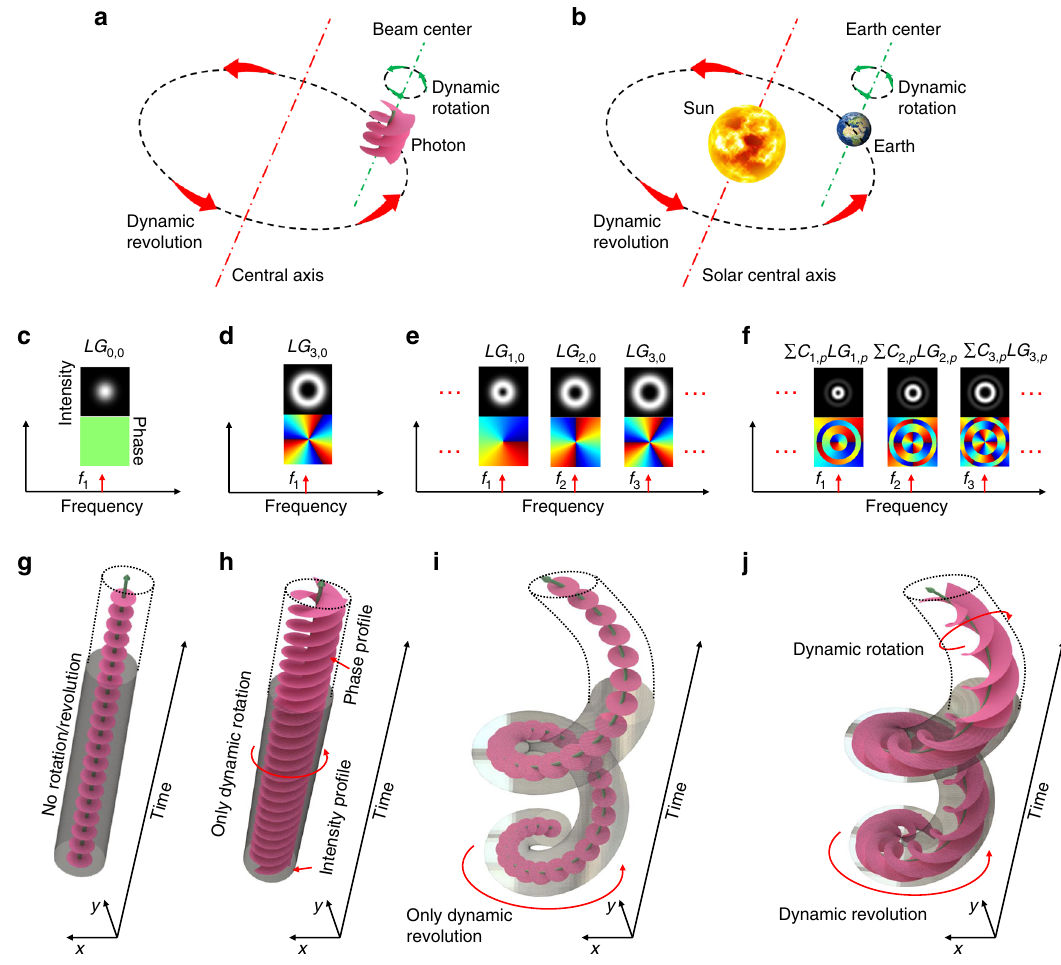
Fig. 1 Generating a spatiotemporal beam exhibiting both dynamic rotation and revolution. a , b Illustration of a light beam that dynamically rotates around its beam center and revolves around another central axis; this is analogous to the earth orbiting around the sun, exhibiting both rotation around its Earth center and revolution around the solar central axis. c , g A Gaussian beam on a single frequency exhibits no dynamic rotation/revolution. d , h An LG 3,0 beam on a single frequency exbibits only dynamic rotation. e , i Using multiple frequency comb lines, in which each carries an LG ‘; p mode with a different ‘ value and the same p value, to generate a Gaussian-like beam dot exhibiting only revolution around a central axis. f , j Using multiple frequency comb lines, in which each carries a superposition of multiple LG ‘; p modes with one different ‘ value and multiple p values, to generate an LG 3,0 beam exhibiting both dynamic rotation and